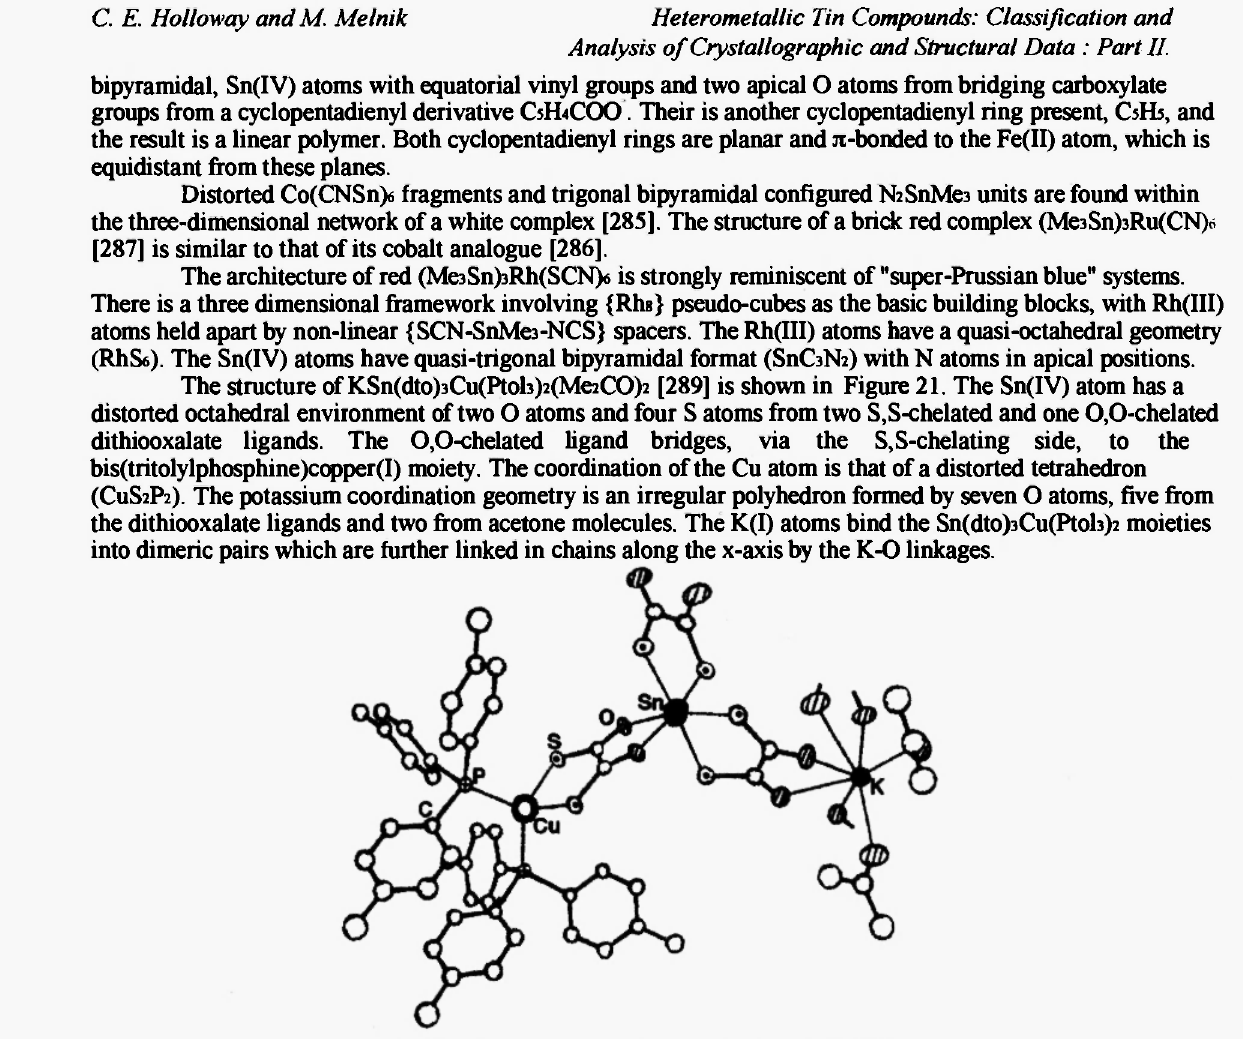
Fig.21. Structure of KSn(dto)3Cu(Ptob>2